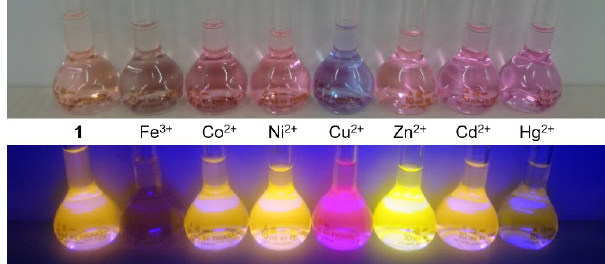
Figure 3. Photos of BODIPY 1 solution (3 µM) in the presence of different metal cations (300 µM) in acetonitrile. The fluorescence color was observed under excitation at 365 nm.